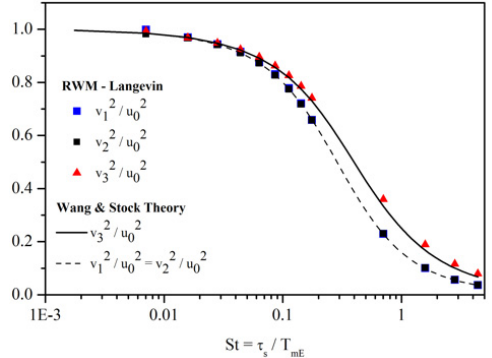
Figure 18. Normalized variance of particle velocity (g ≠ 0).